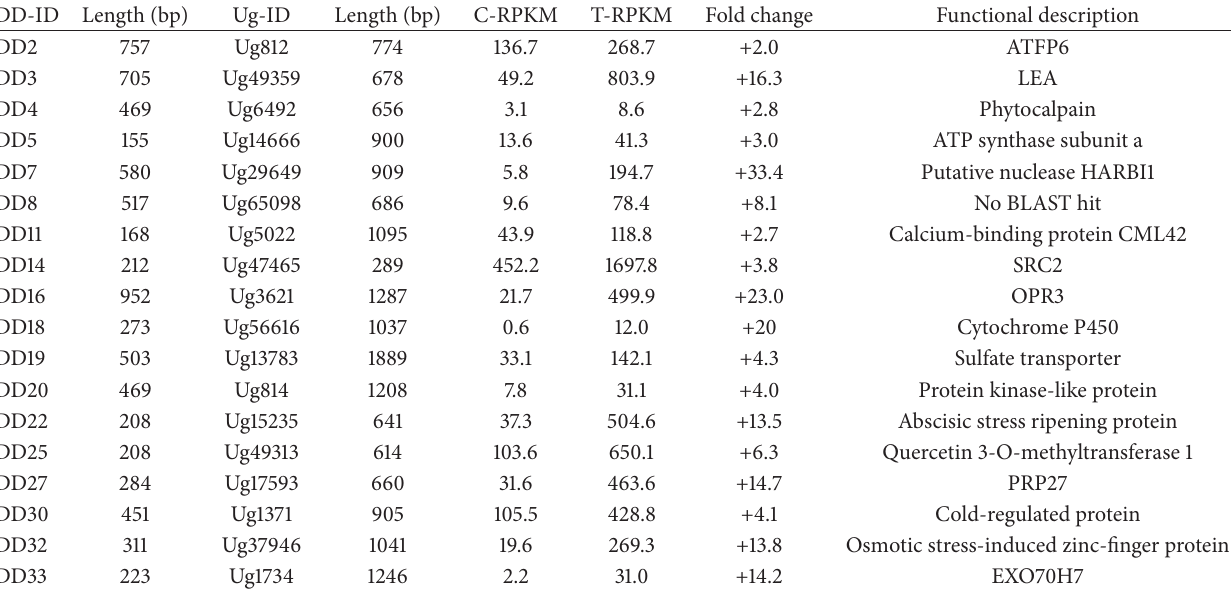
Table 2: Local BLAST analysis based on a database of previously assembled R. trigyna transcriptome